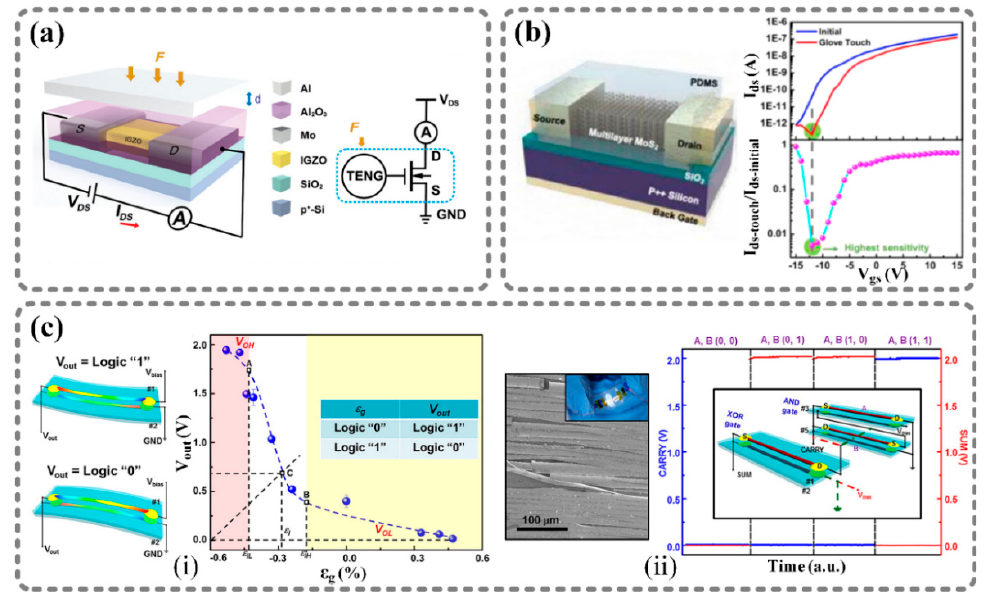
Figure 4. Using nanoenergy to directly modulate electronic signals and construct novel components. ( a ) InGaZnO thin-film transistor: TENG-based tribotronic thin-film transistor for tactile detection [66]. ( b ) Tribotronic MoS 2 touch memory: zero-writing-power tribotronic touch memory [67]. ( c ) Epitaxial GaN nanobelt: logic devices based on piezoelectric transistors [68]. (i) GaN nanobelt piezotronic inverter. (ii) Piezotronic half-adder composed of GaN nanobelt piezotronic NAND and NOR logic gates. Reproduced with permission from John Wiley and Sons [66], Elsevier [67], and American Chemical Society [68].